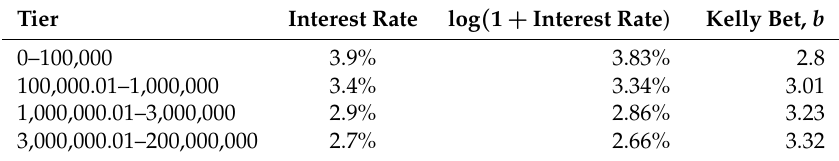
Table 1. Margin loan interest rates (for U.S. dollars) at Interactive Brokers, 12 March 2019.